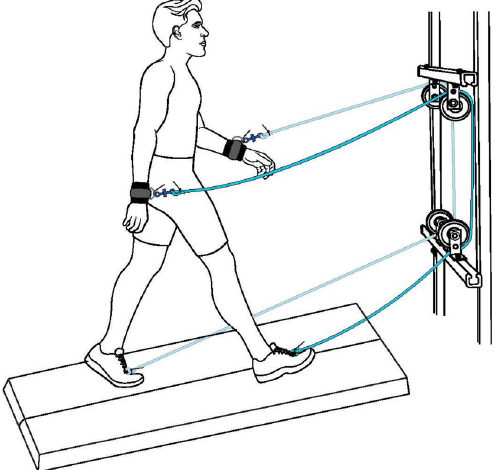
Fig 1. Arm-leg rope pulley system. Subjects walked on a treadmill while attached to a simple rope-pulley device that connects the ipsilateral arm and leg via a rope. Figure modified from Vega and Arellano [5].